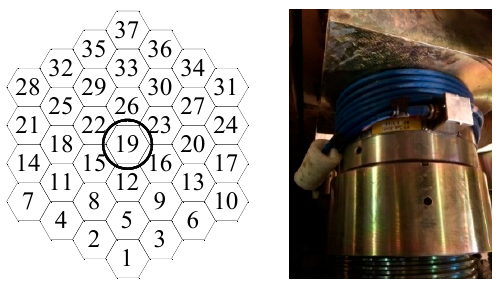
Figure 14. Schematic diagram of cable strand and the photo of the pressure sensor installment.